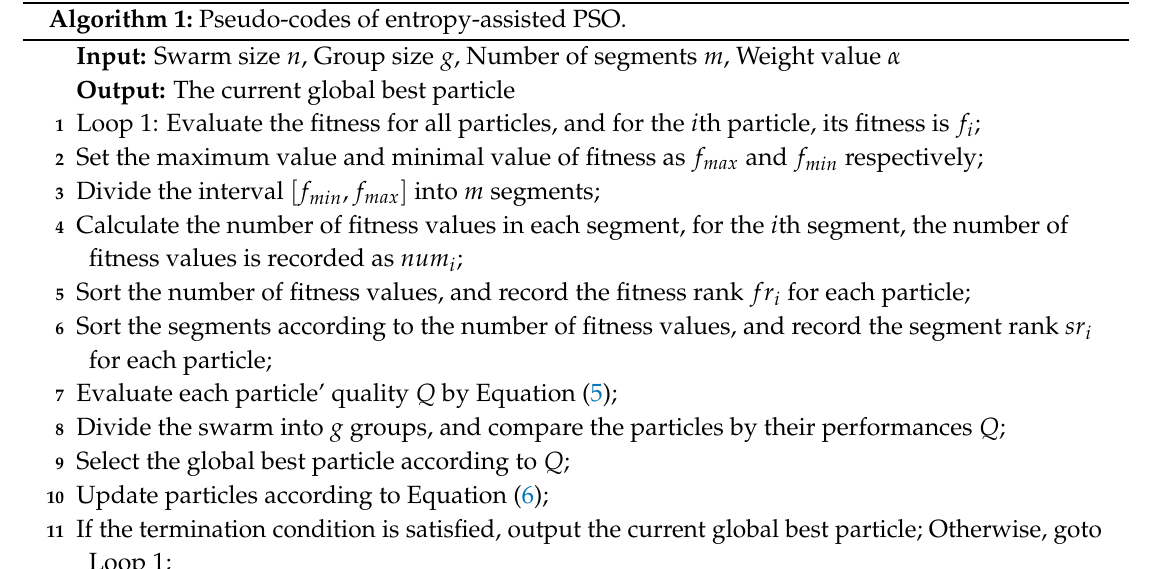
Algorithm 1: Pseudo-codes of entropy-assisted